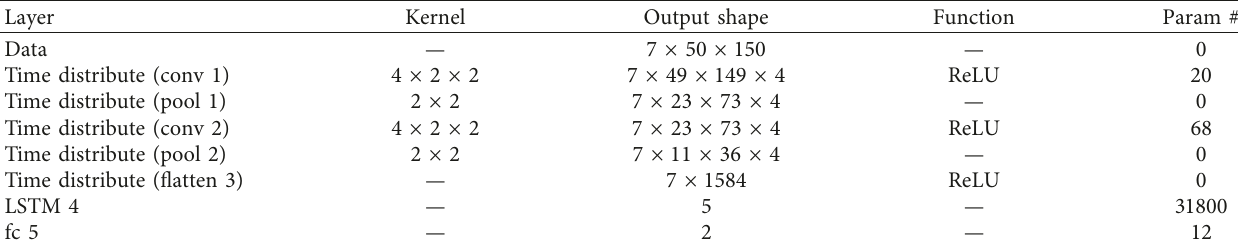
Table 2: Trainable parameters of the